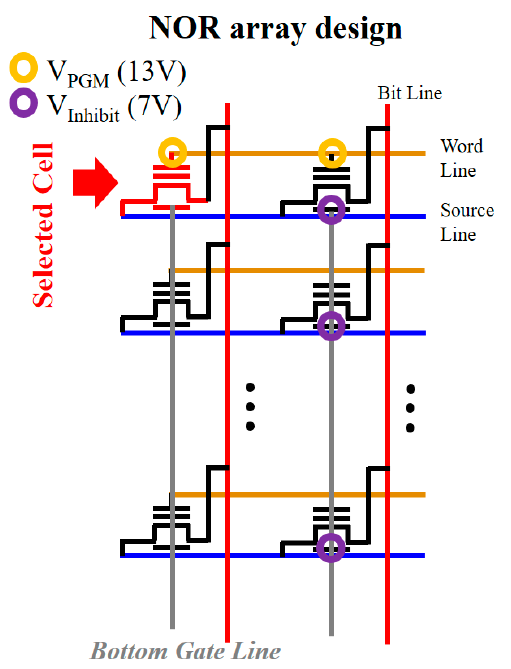
Figure 4. NOR array design for the proposed memory device structure. The newly added bottom gate line is perpendicular to the word line for selective programming.